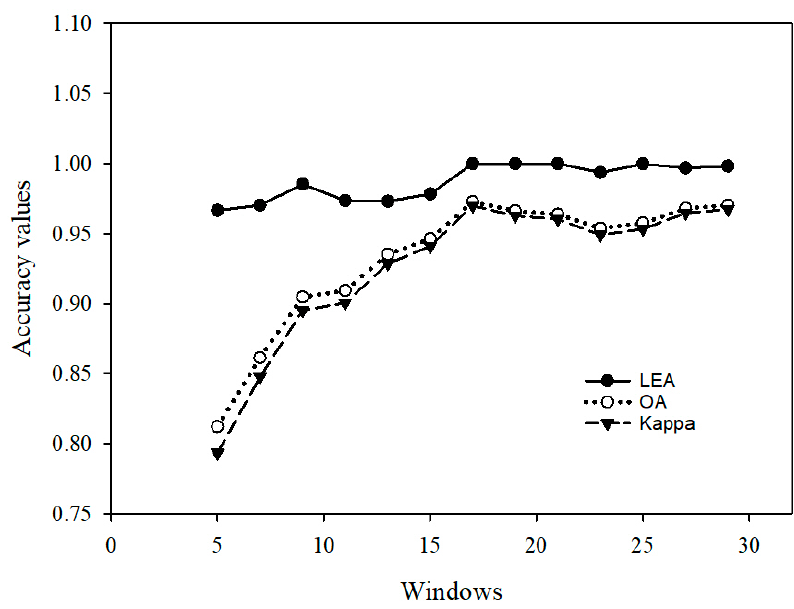
Figure 8. Changes of the classification accuracy using CBAM-P-Net (Channel First).